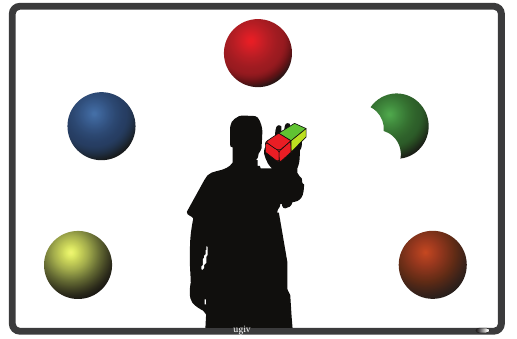
Figure 3: Rehabilitation session introducing mirror feedback.